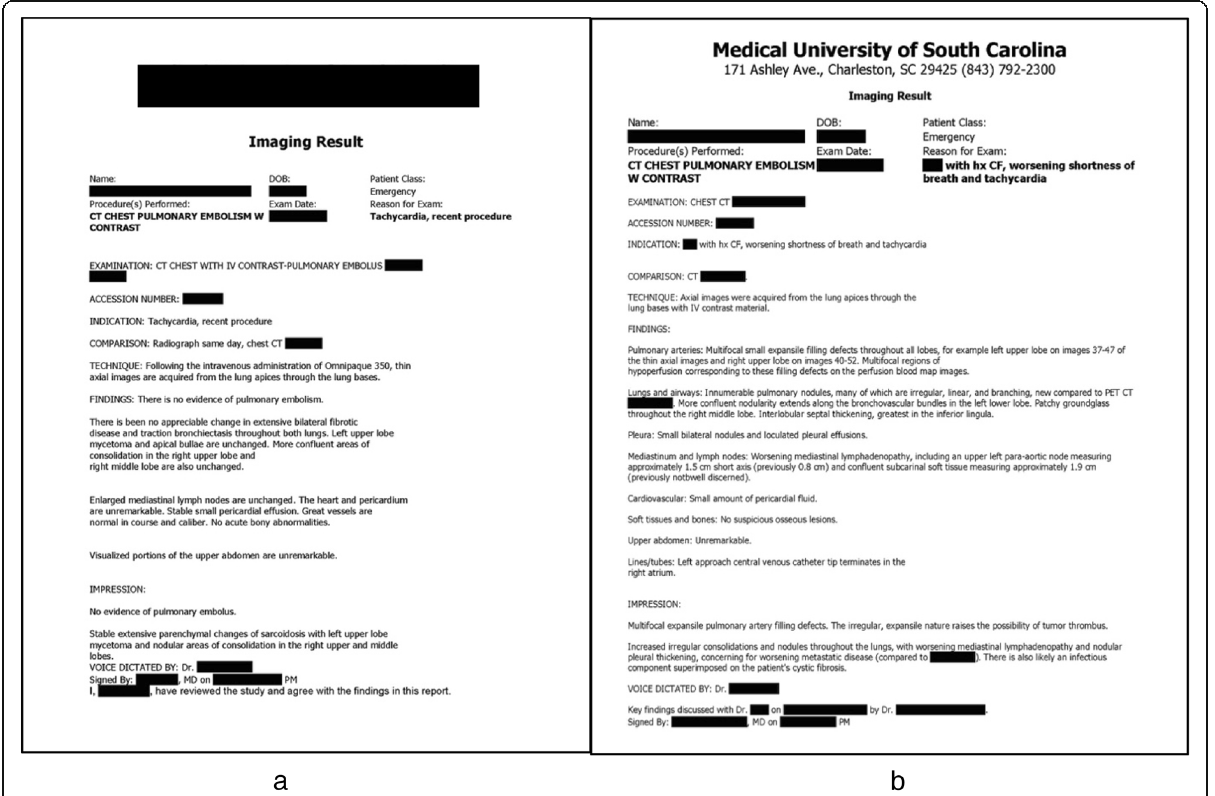
Fig. 1 Examples of unstructured ( a , used for testing) and structured ( b , used for training) radiology